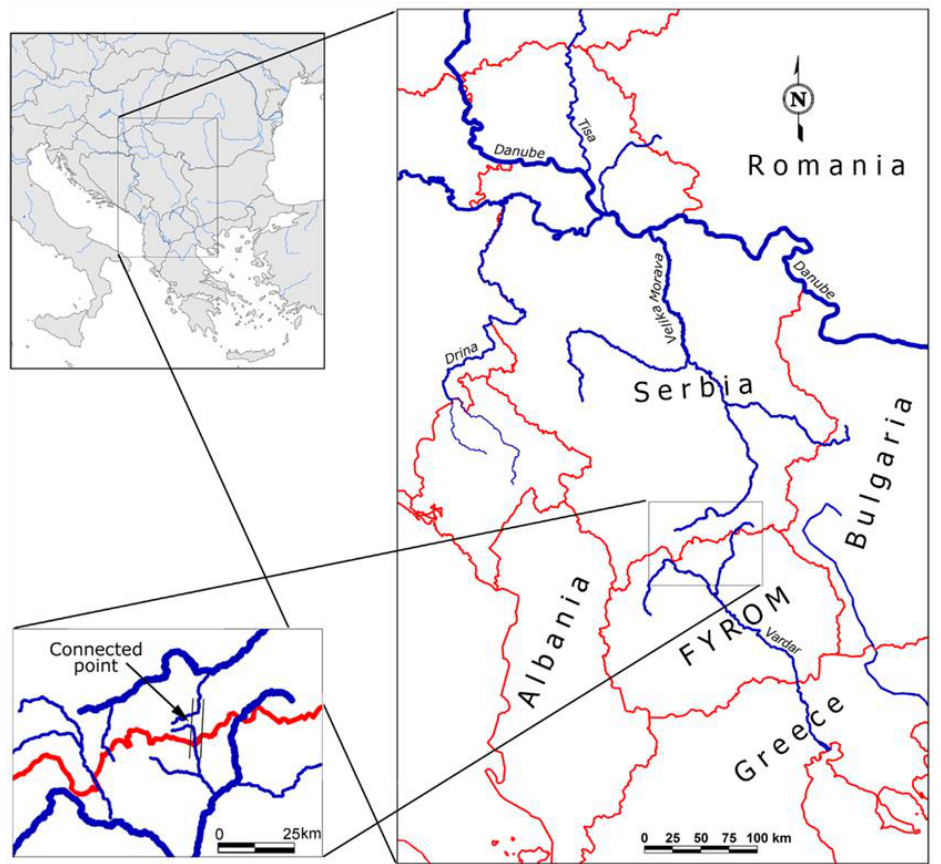
Figure 1: Proposed canal connecting the Morava and Vardar